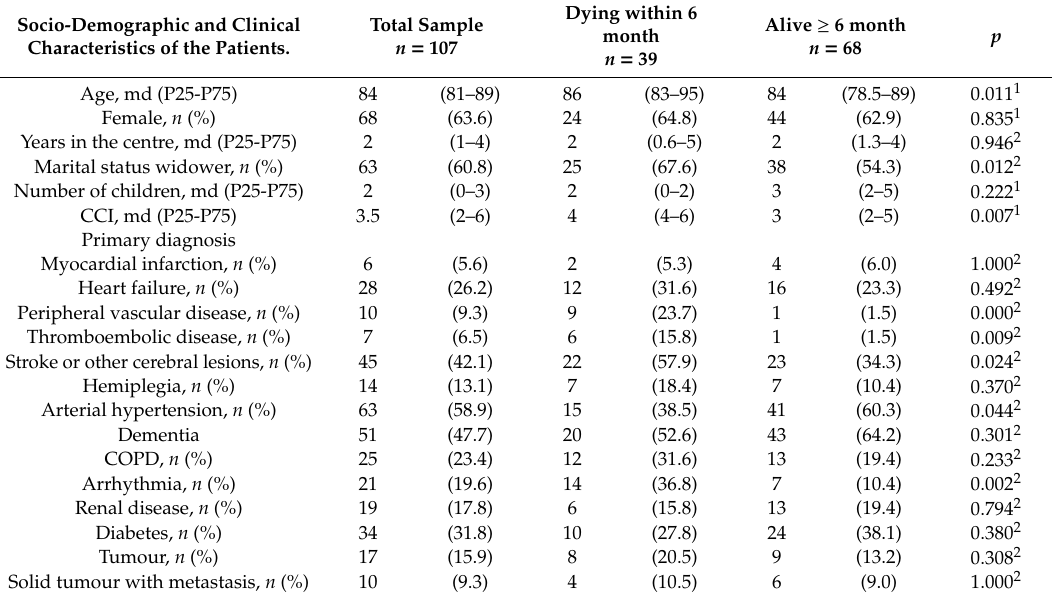
Table 1. Socio-demographic and clinical characteristics of the